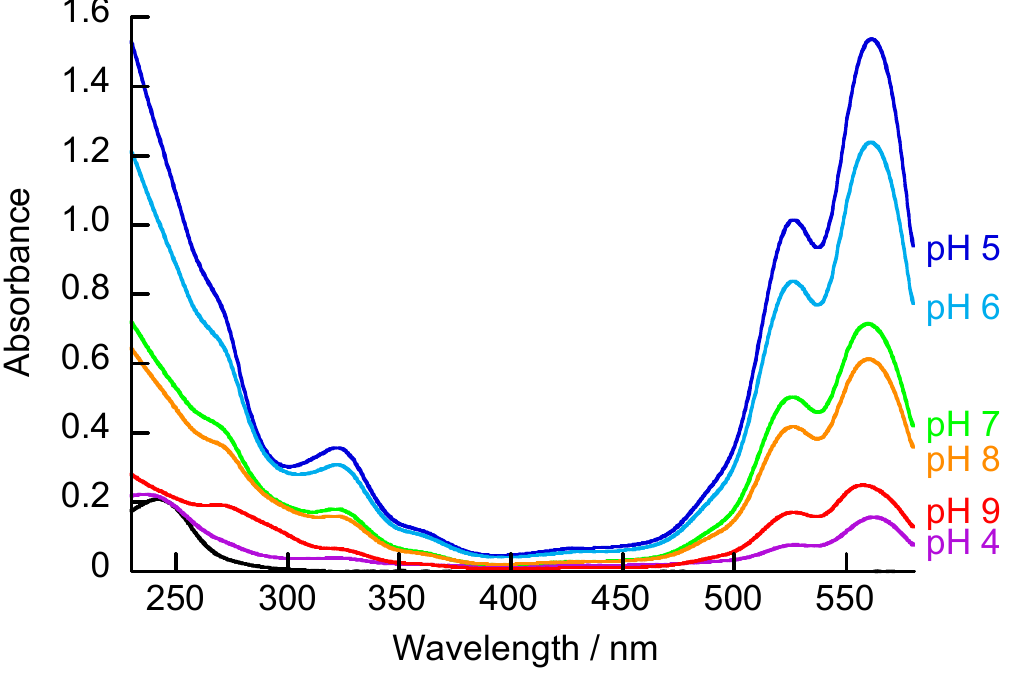
Figure 8. UV-vis absorption spectra of (PBA-PAMAM / PVA) 5 films after immersion in RB solution at different pHs. The black line is the UV-vis absorption spectrum of the film before immersion in RB solution.